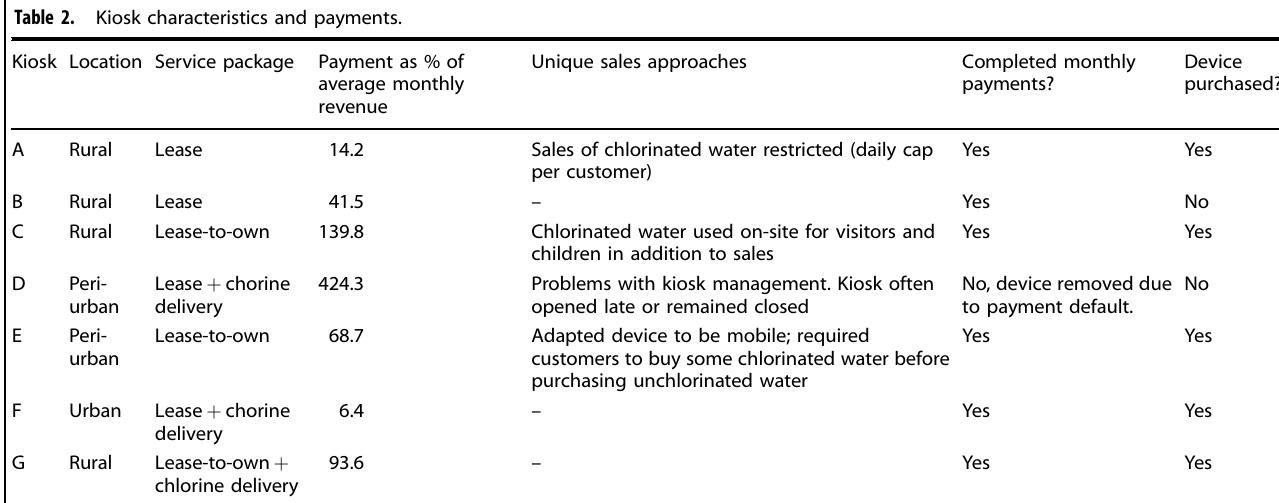
Table 2. Kiosk characteristics and payments.